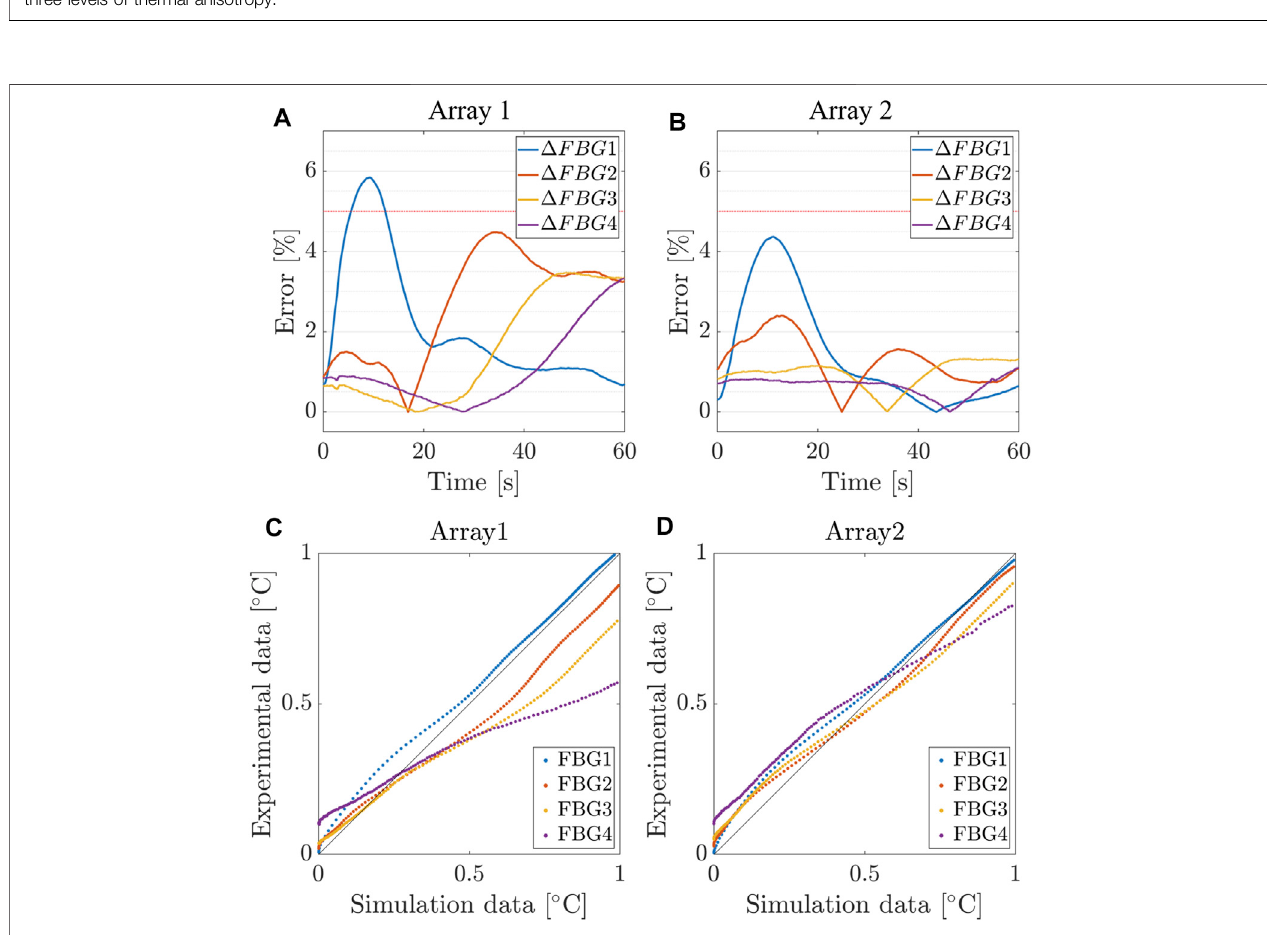
FIGURE 9 | Relative error between simulated and measured temperatures for the fi rst 4 FBGs of Array 1, 2. (A,B) Relative error and (C,D) Pearson correlation coef fi cient between the numerical and the average experimental temperature at each instant of the RFCA.